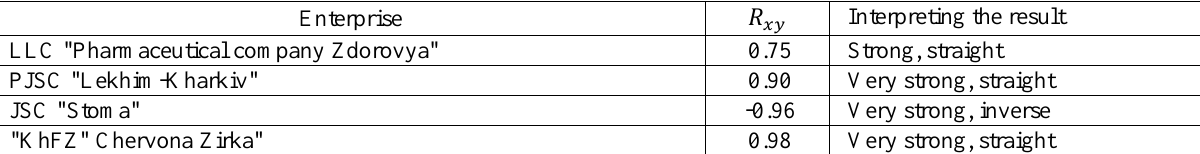
Value of the pair correlation coefficients between the values of net profit and the stocks of the Kharkiv